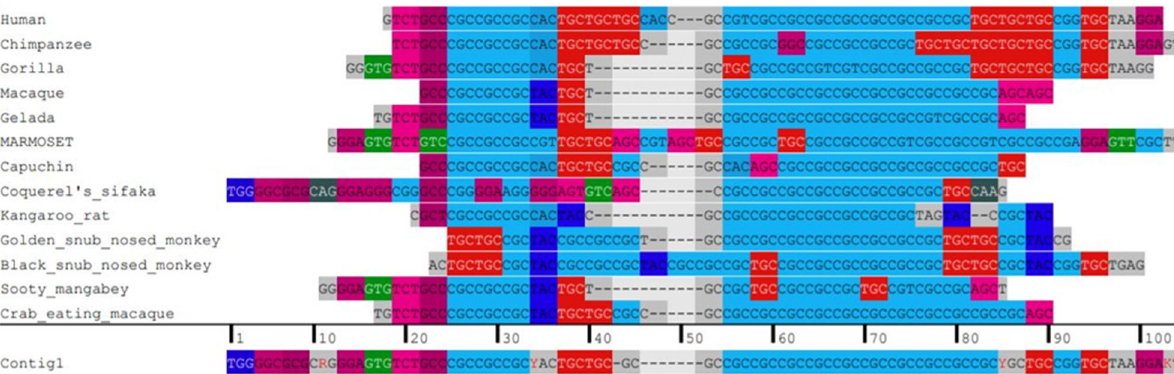
Figure 3. Sequence alignment of the PRKACB region encompassing the (GCC)-repeat in various primates. Each species revealed complex and unique stretches of (GCC)-repeats. Contig1 indicates the possible ancestral sequence across the selected species. Triplet nucleotides which may be remnants of GCC sequences are detectable in the ancestral sequence.